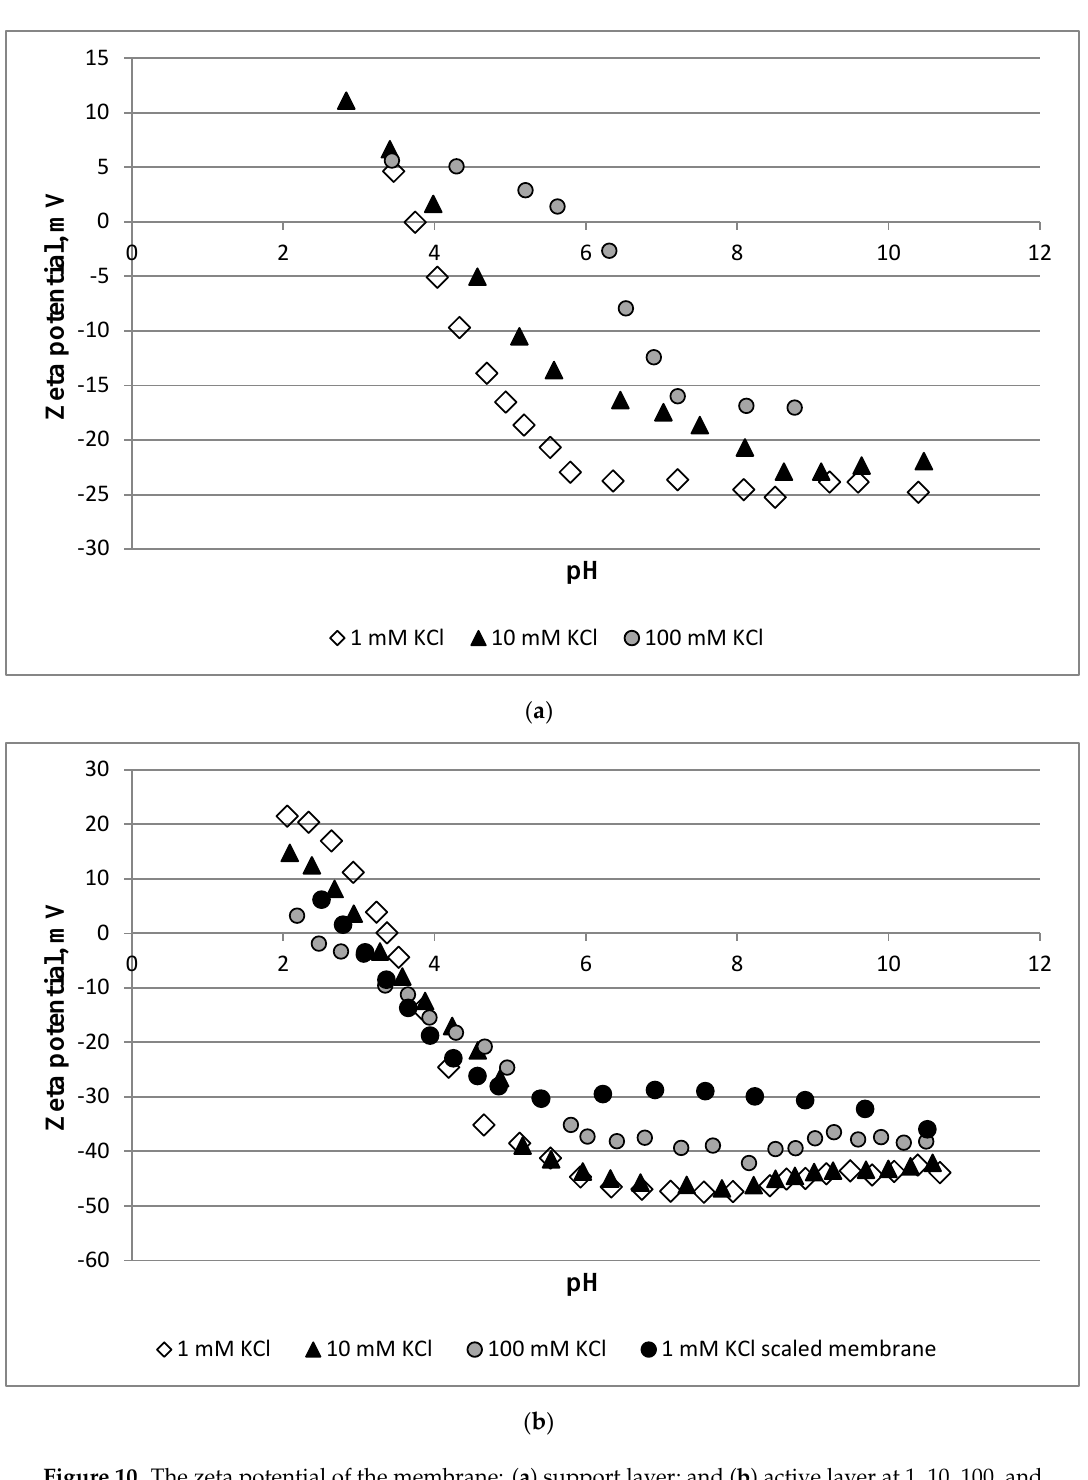
Figure 10. The zeta potential of the membrane: ( a ) support layer; and ( b ) active layer at 1, 10, 100, and 1 mM KCl scaled membrane. Scaling conditions: concentrations of NaCl, CaCl 2 , and Na 2 SO 4 are 1.754, 6.132, and 4.487 g / L, respectively; SI = 2.45; 12.5 cm / s cross-flow velocity; the feed and draw solutions were circulated counter-currently; and an AL-FS orientation.